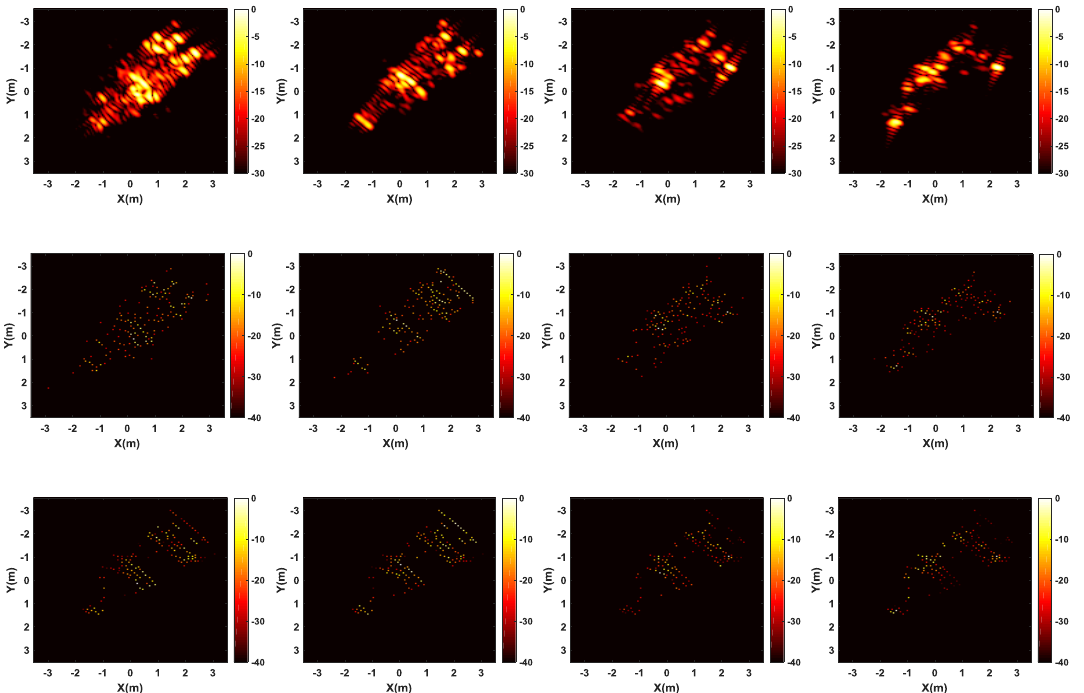
Figure 17. Three method’s reconstructed SAR images each of 5 ◦ width with maximum number of measurements. Columns left to right correspond to images centered at − 7.5 ◦ , 2.5 ◦ , 15 ◦ , 27.5 ◦ degrees azimuth. Rows correspond to FBP method (top row), independent CS processing (middle row) and joint CS processing (bottom row).